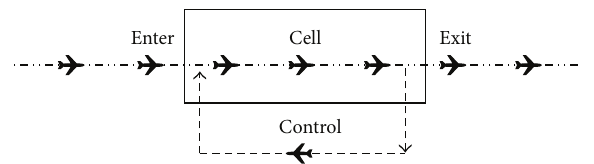
Figure 2: One-dimensional cell transmission model of air traffic flow in single